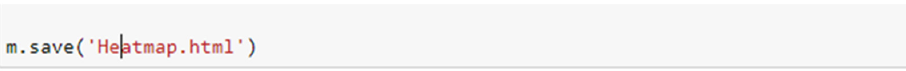
Figure 11. Finished MVTC heatmap. View from the inside of the Jupyter environment. To be able to view the output outside this environment, we shall use the save func- tion and save the map as a heatmap file in .html format to the local storage (Figure 12).